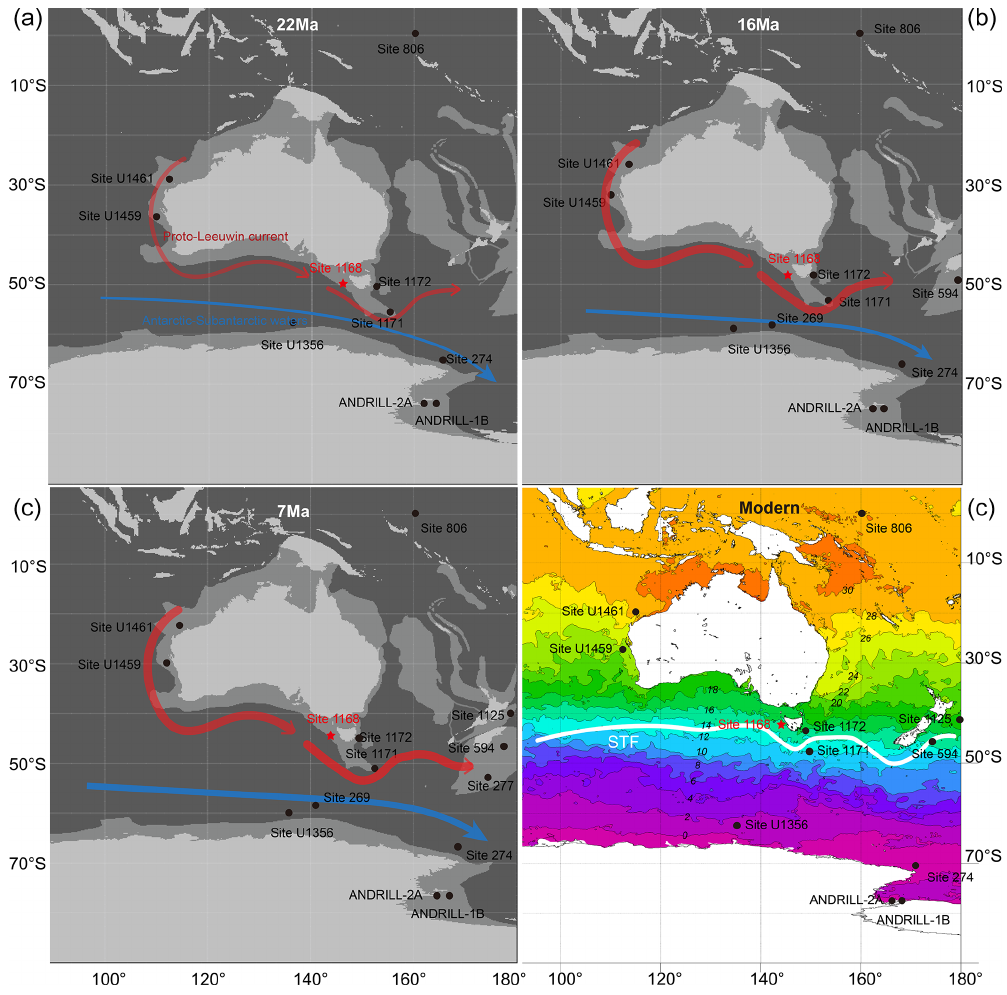
Figure 1. Neogene paleogeographic maps of the Australian–Antarctic sector, with the Deep Sea Drilling Program, Ocean Drilling Program and Integrated Ocean Drilling Program site locations referred to in this study. (a, b, c) Reconstructed map of studied area using GPlates (Torsvik et al., 2012; Van Hinsbergen et al., 2015) with inferred surface ocean currents (solid red and blue lines; De Vleeschouwer et al., 2019; Jackson et al., 2019; Sauermilch et al., 2021; Evangelinos et al., 2022). The thickness of the lines denotes the relative strength of the currents. The edge of the light-grey fill denotes present-day shorelines. The dark-grey contours indicate the edge of continental plates. Compiled sites and the site of this study are shown with black circles and a red star, respectively. (d) Modern map (modified from NOAA, https: //www.ospo.noaa.gov/Products/ocean/sst/contour, last access: 13 March 2023) of the studied area filled with modern sea surface temperature, which is indicated by colours and contours and numbers on the contours. The white line indicates the subtropical